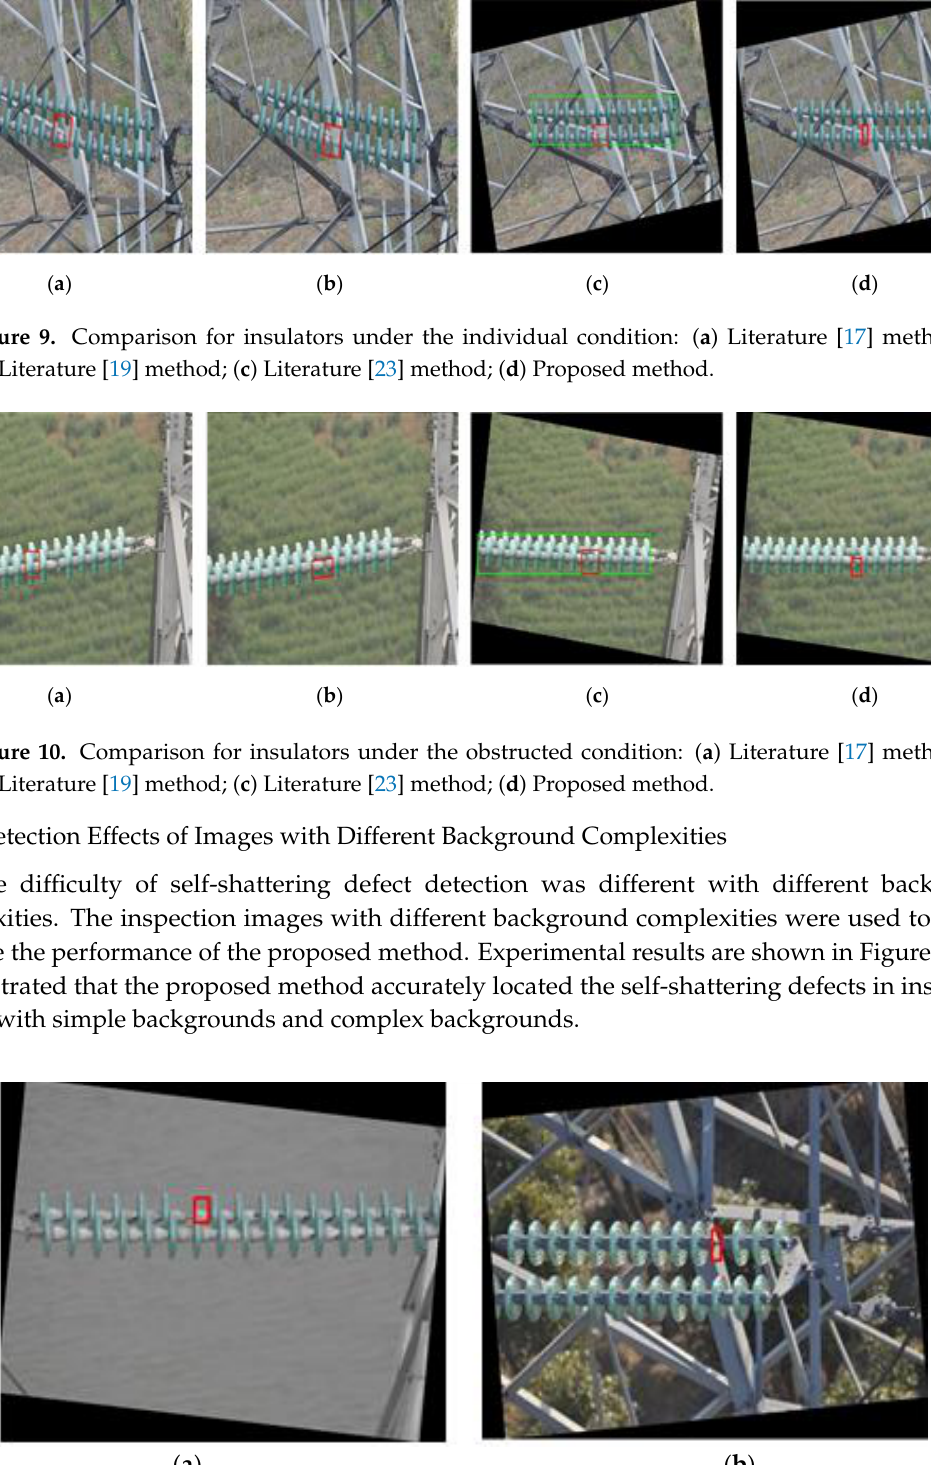
( d ) Figure 8. Test results: ( a ) Original image; ( b ) Detected lines; ( c ) Connected regions; ( d ) Defect localization. 4.2. Robustness Analysis In this section, the robustness of the proposed method is analyzed through comparison with existing insulator self-shattering defect detection methods.